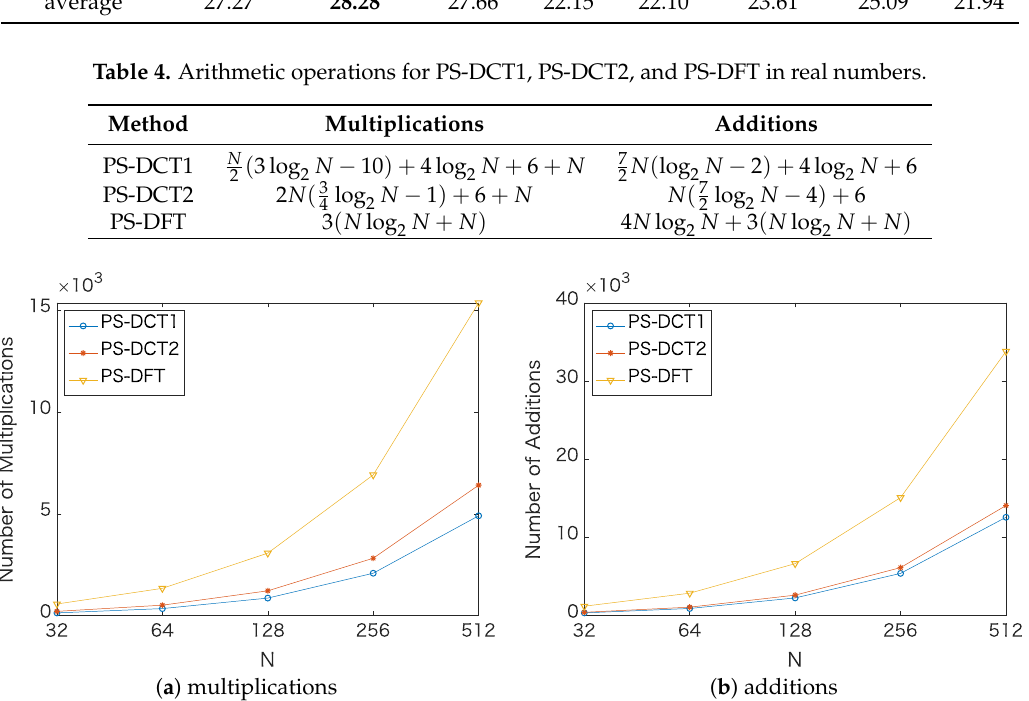
Figure 7. Comparison of the arithmetic operations based on Table